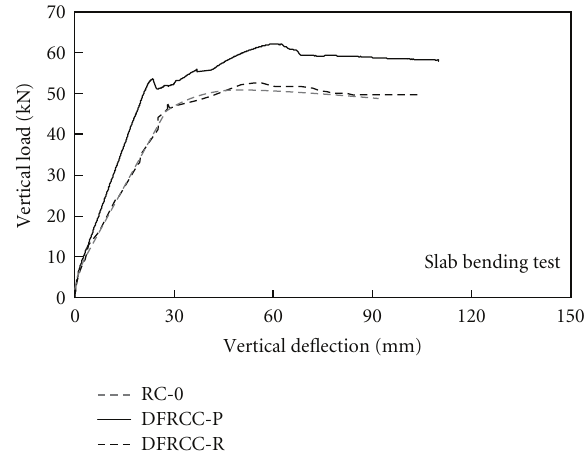
Figure 13: Measured load and deflection curves of slab specimens.